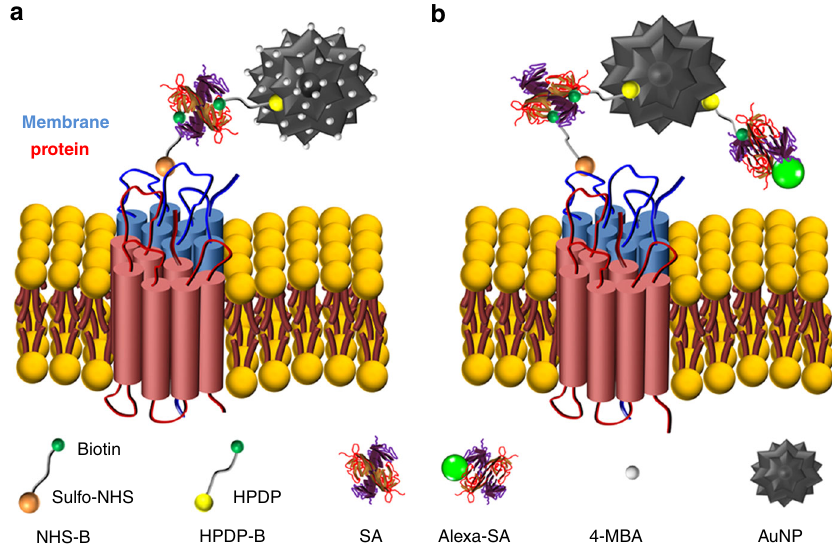
Fig. 1 Bioconjugation strategy for cell surface labelling using AuNP. a Explanatory sketch illustrating the structure of the pH nanosensor: the surface of AuNP is functionalized with 4-MBA and HPDP-B. The sulfo-NHS moiety of the biotinylation reagent NHS-B reacts with primary amines in lysines or amino- termini of membrane proteins such as receptors, pores, channels, carriers, pumps, integrins, or enzymes. Two of the four active sites of streptavidin (SA) provide the link between the biotins of NHS-B anchored to proteins and HPDP-B conjugated to AuNP. b Conjugated AuNP labelled with Alexa-SA: the attachment of the nanoparticles to the cell membrane was con fi rmed using AuNP functionalized with HPDP-B, some biotins of which reacted with Alexa- SA to enable visualization by